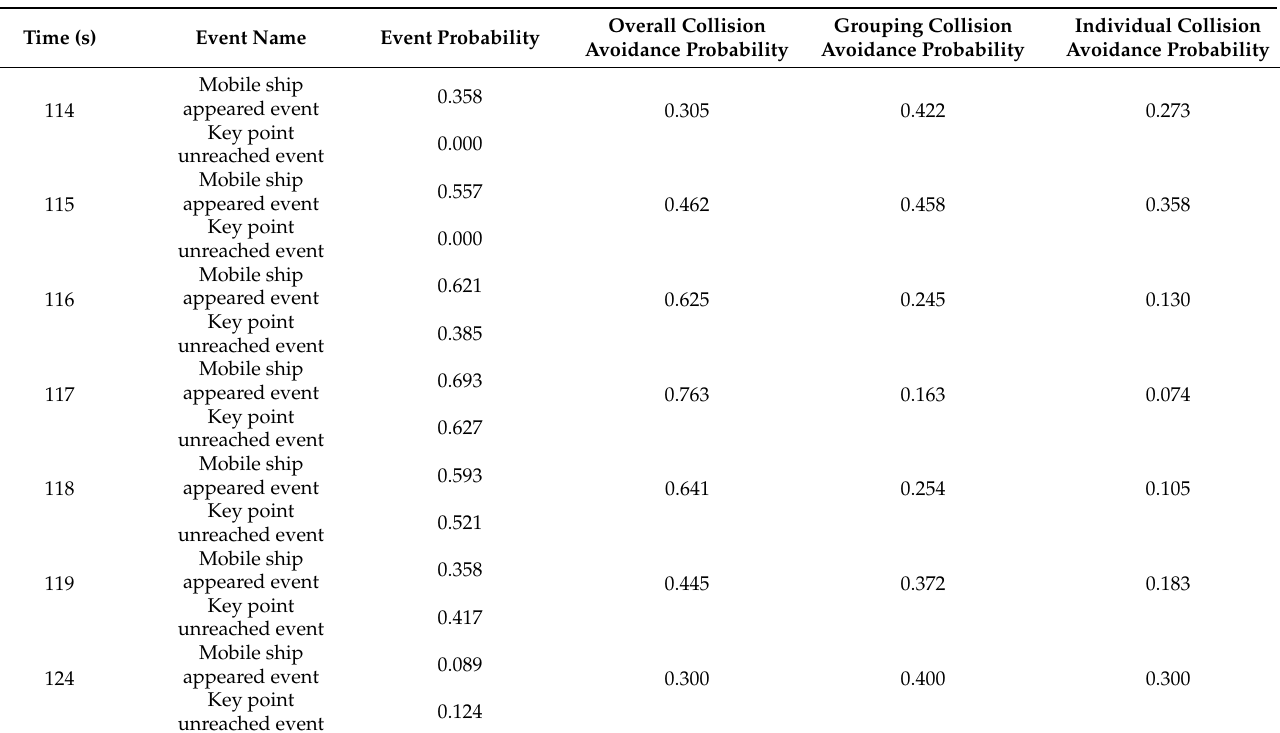
Table 4. Synergistic perception output